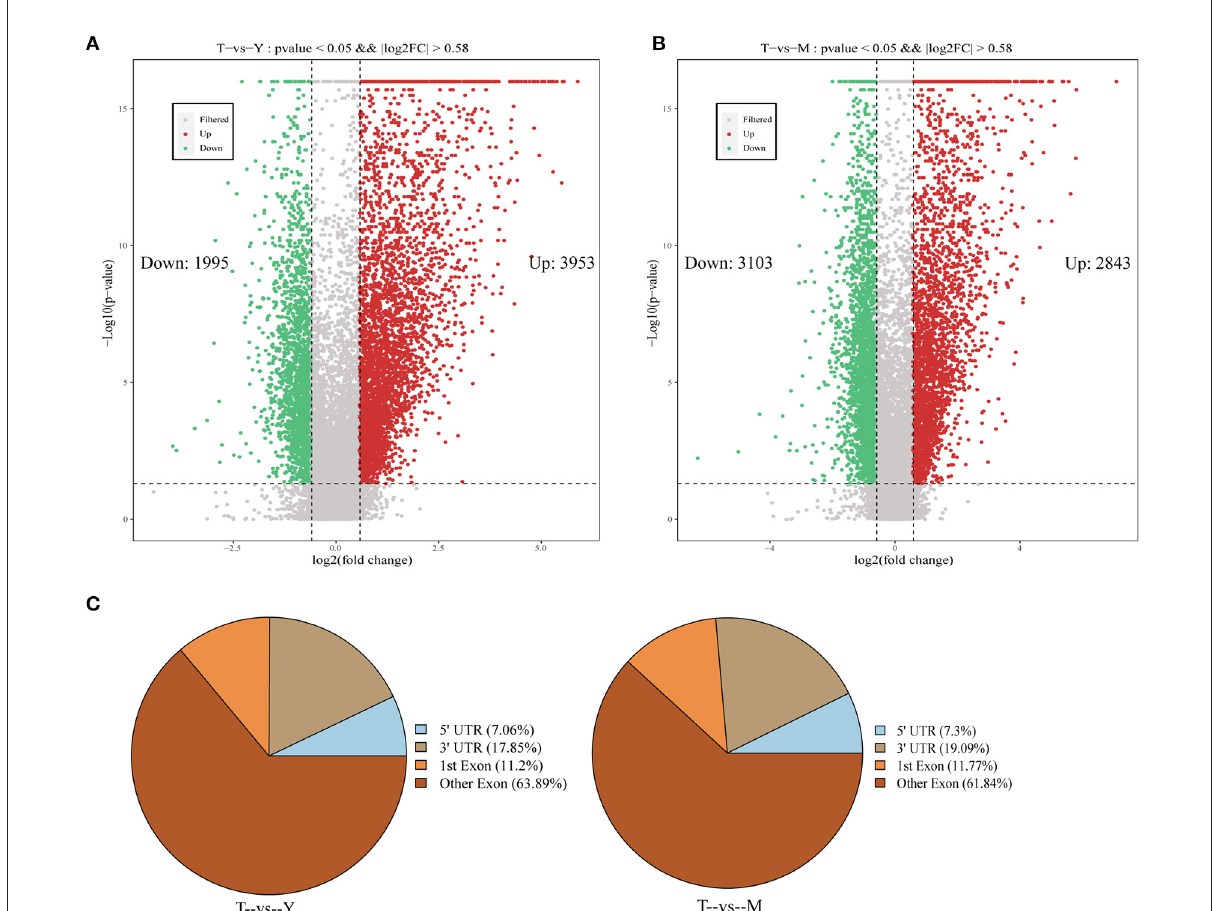
FIGURE4 Identification and annotation of differentially methylated peaks. (A,B) Volcano plots demonstrating differentially methylated peak distributions. (C) Pie charts representing the annotation of DMPs associated with different gene regions.